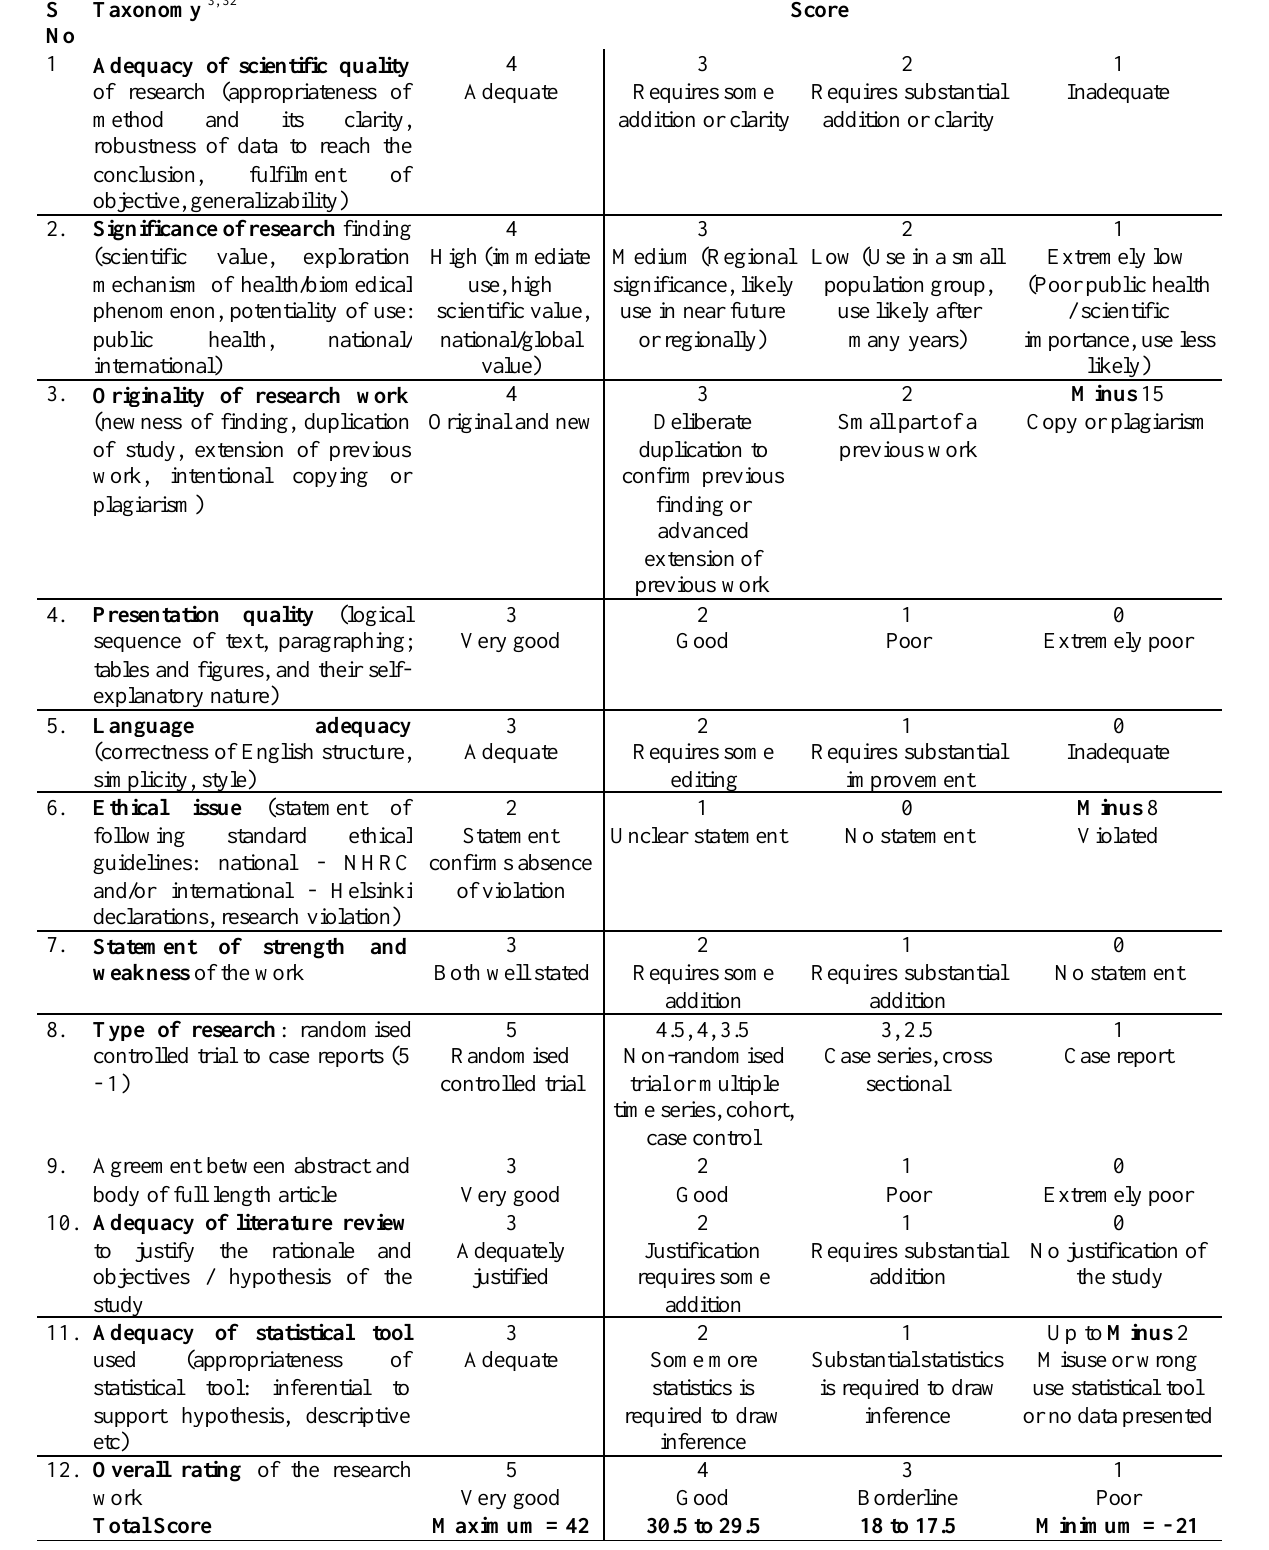
Table I : The Criteria for reviewing of paper submitted to a biomedical journal (Reviewer’s